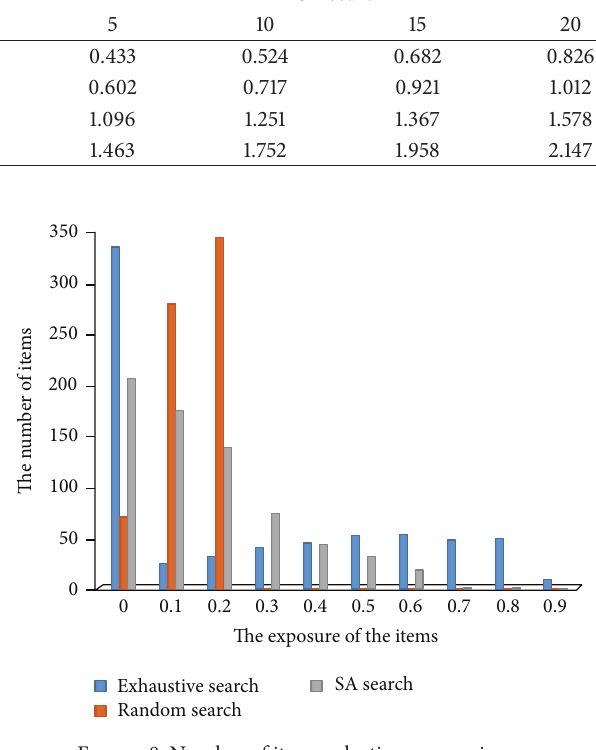
Figure 8: Number of items selection